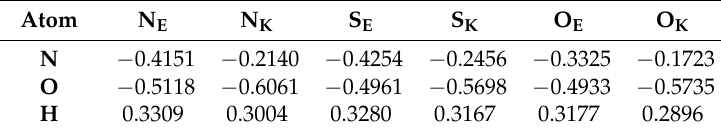
Table 4. ChelpG charges in the ground state for the enolic and ketonic species of the imidazolic, oxazolic, and thiazolic heterocyclic systems, regarding the atoms involved in intramolecular hydrogen bonding. Atom N